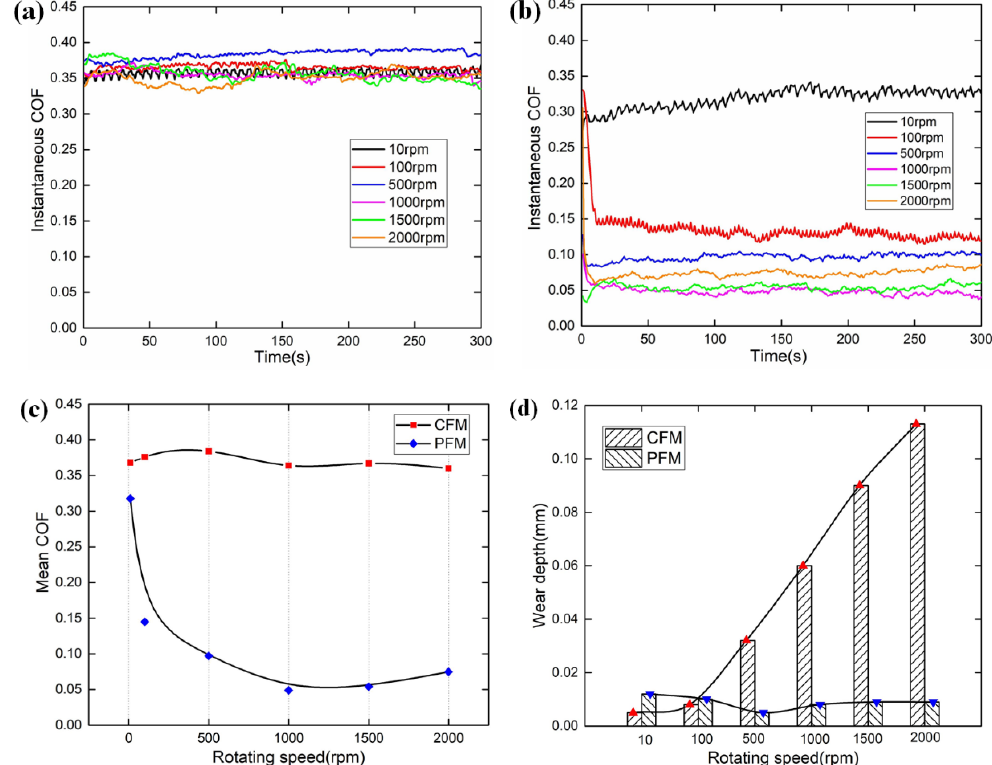
Figure 6. Experimental results under the rotating speed condition. ( a ) Instantaneous COF of CFM; ( b ) instantaneous COF of PFM; ( c ) mean COFs of the CFM and PFM; ( d ) wear depths of the CFM and PFM.